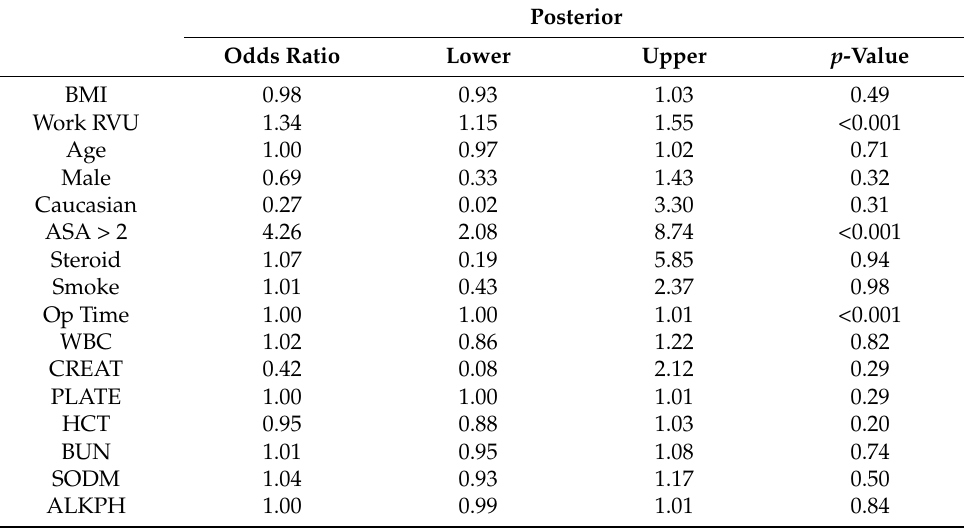
Figure 3. Calibration curves of the five machine learning algorithms for posterior cases. The multivariable regression indicated that increased Work RVU, elevated ASA class, and longer operating times were linked to longer LOS for posterior cases (Table 3). A forest plot of the regression results is graphed in Figure 4. Table 3. Results of the multivariable regression analysis for posterior